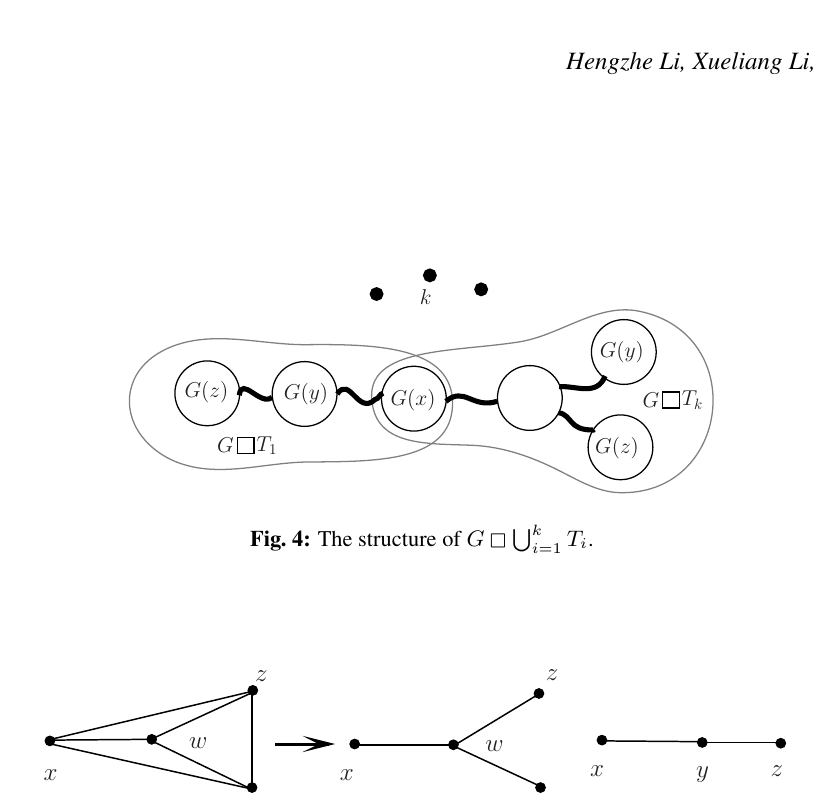
Fig. 4: The structure of G